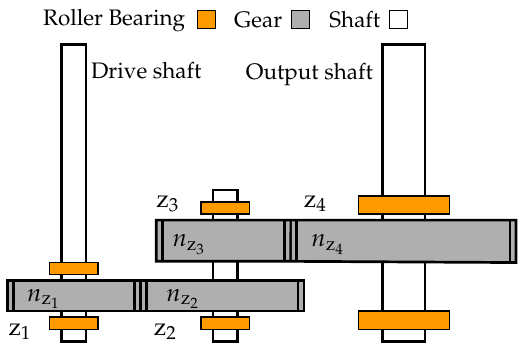
Figure 2. Schematic structure of the examined